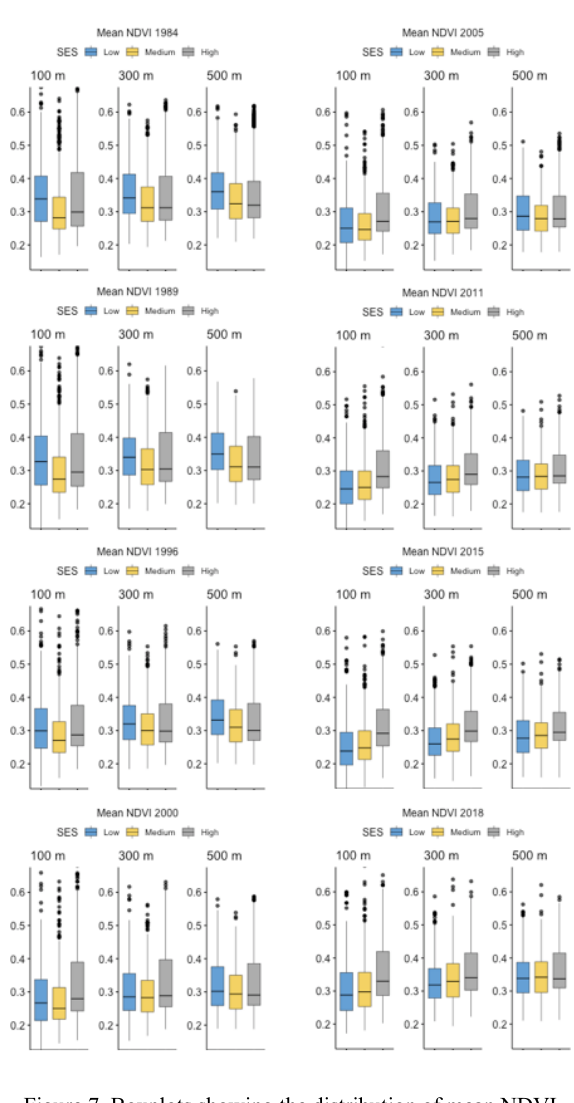
Figure 7. Boxplots showing the distribution of mean NDVI values by SES, buffer size, and year.